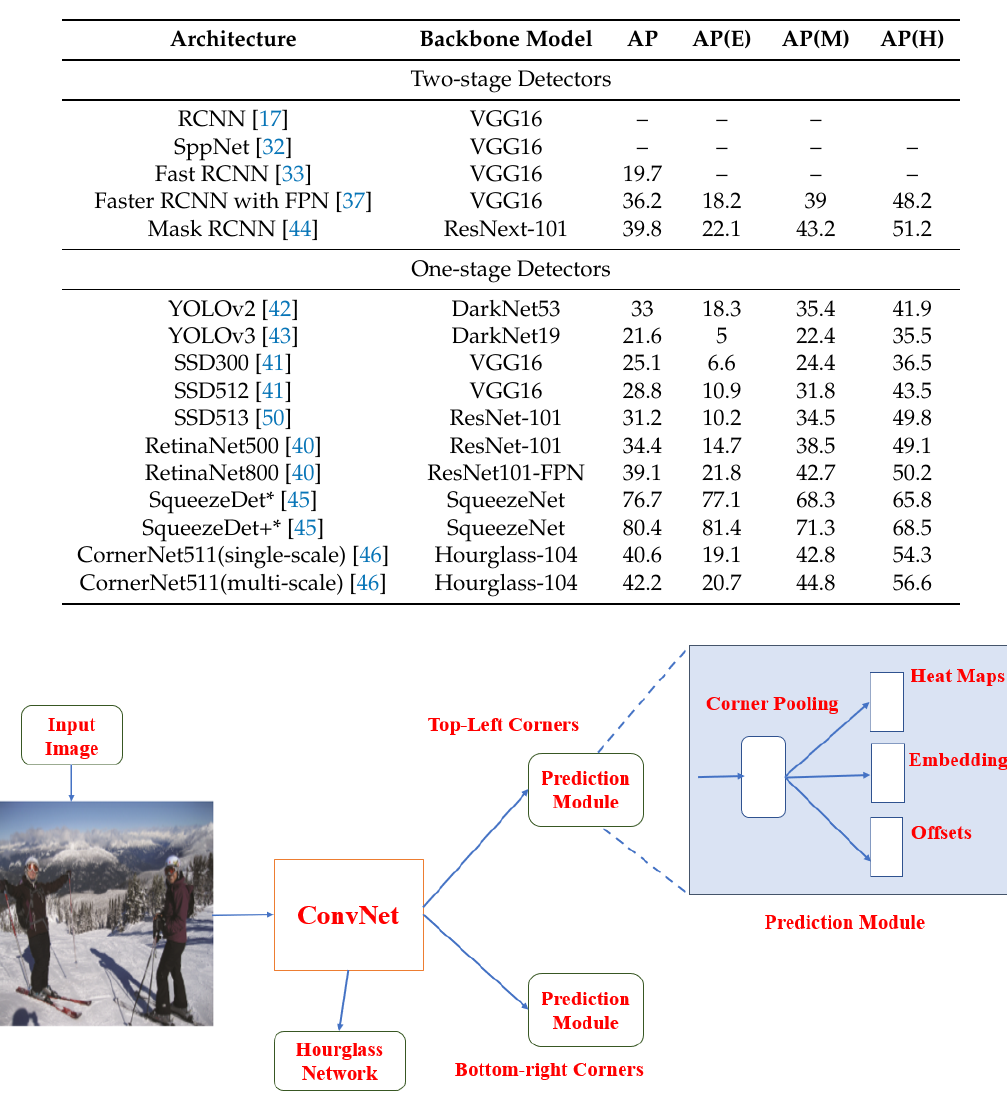
Table 2. Comparison of deep learning based object detection performances on MS-COCO test-dev dataset. (Note: SqueezeDet* and SqueezeDet+* models are trained on Kitti dataset. AP(E), AP(M), and AP(H) refer to average precision for easy, medium, and hard cases.)